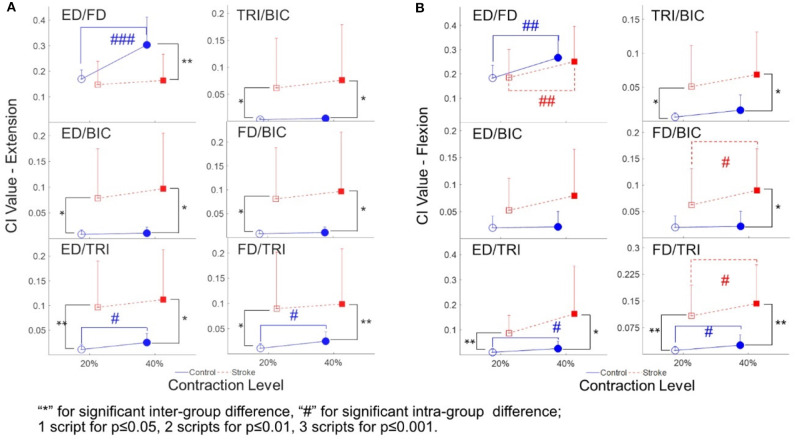
The CI between the muscles of both stroke subjects (squares) and unimpaired subjects (circles): (A) The CI values of different muscle pairs during the extensions; (B) the CI values of different muscle pairs during the flexions. 1 superscript for p ≤ 0.05, 2 superscripts for p ≤ 0.01, 3 superscripts for p ≤ 0.001. The significant inter-group difference is indicated by * (independent t-test), and # is used to indicate the significant intra-group difference (paired t-test).